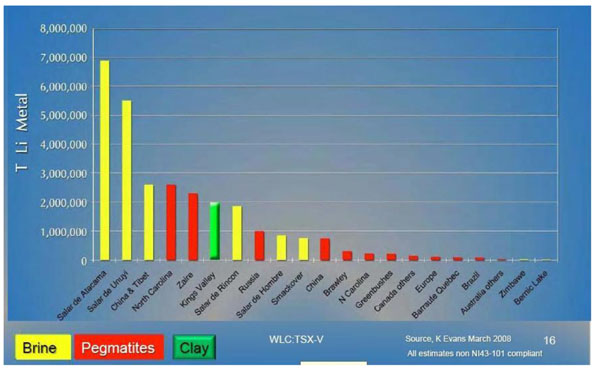
World Lithium Resources [6]